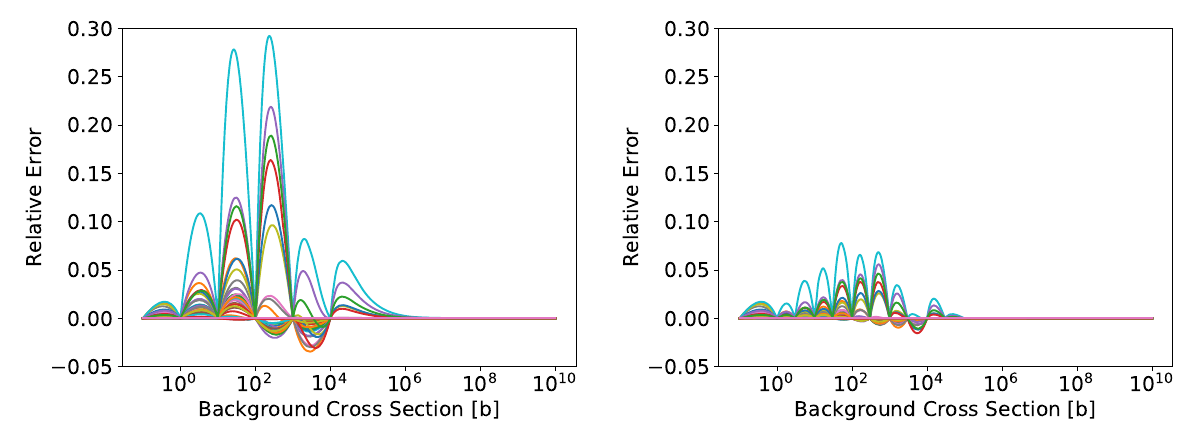
Figure 2: Relative error of interpolated cross sections for each resonant energy group of U-238 in the XMAS 172-group structure using the 7-point dilution grid (left) and the 15-point dilution grid (right) and the TRANSX interpolation